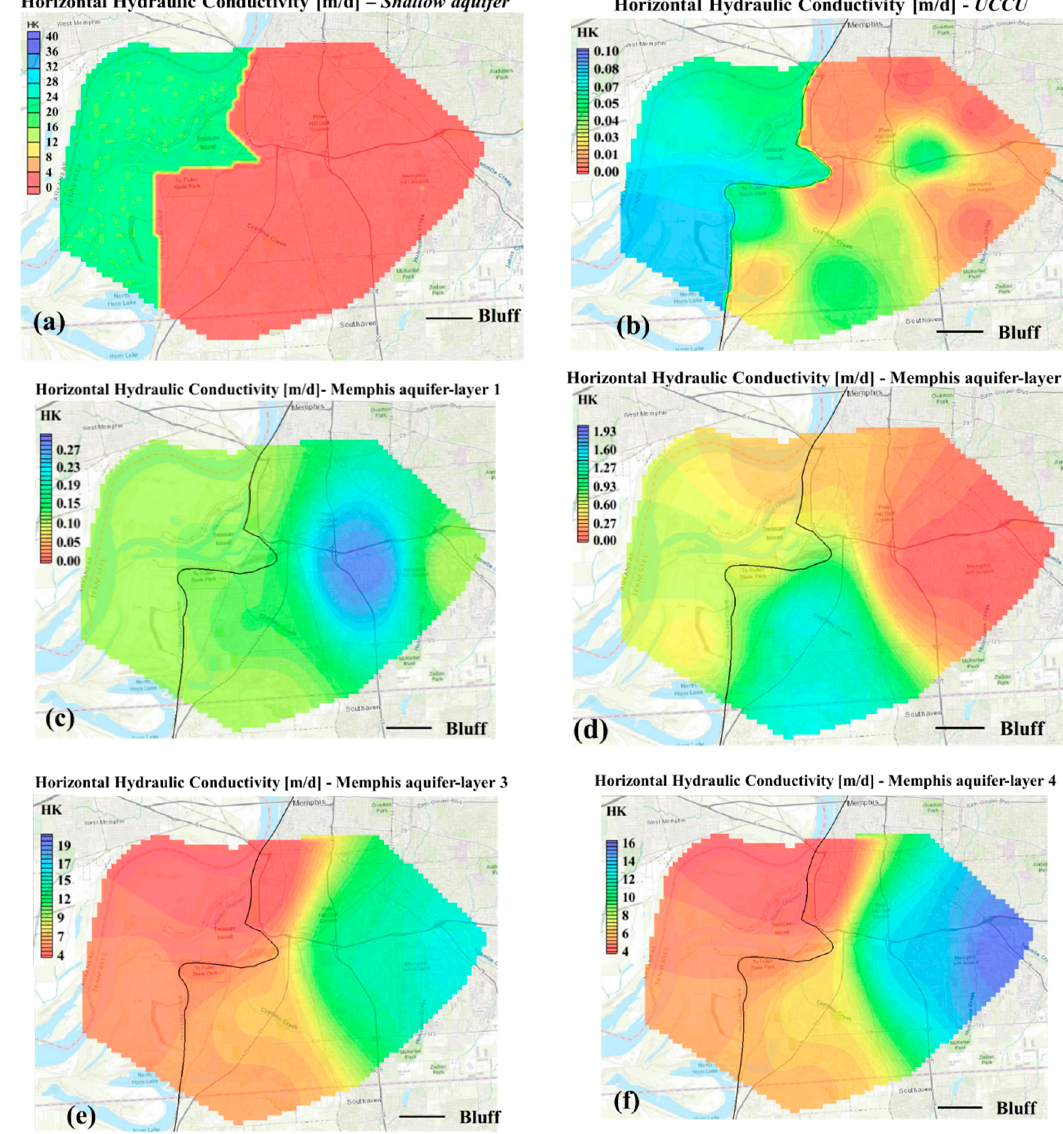
Figure A1. ( a – f ) The horizontal hydraulic conductivities of each numerical layer.